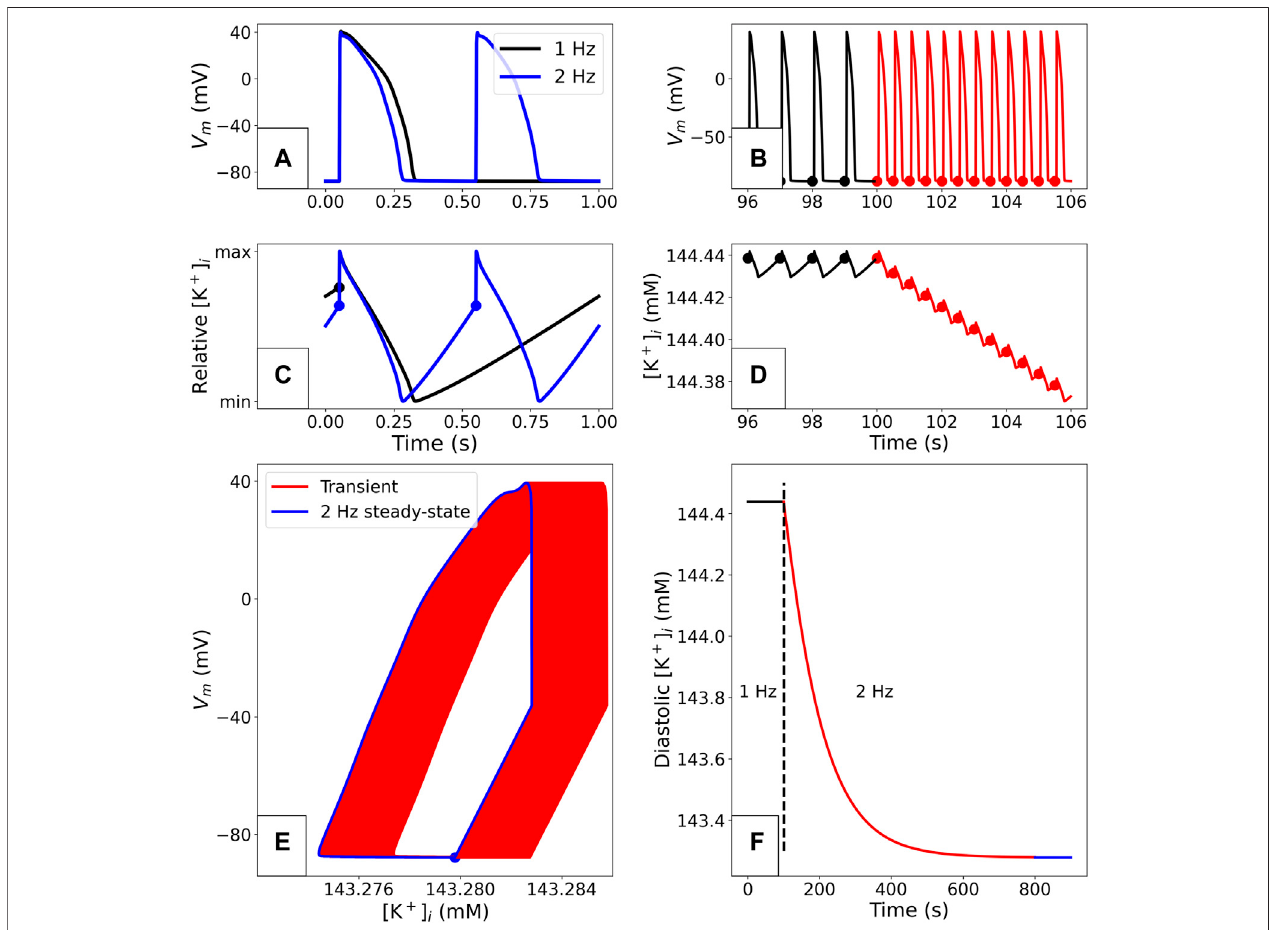
FIGURE 1 | Example of a limit cycle in the O ’ Hara-Rudy CiPA 2017 model (Dutta et al., 2017), using the initial conditions from the published CellML model. The simulation methods are detailed in “ Simulation ” . (A) : Comparison of paced steady-state APs with 1 and 2 Hz pacing. (B) : Adaptation of the voltage pro fi le when the pacing rate is suddenly changed from 1 to 2 Hz. The dots plotted on the traces correspond to the end of the diastolic phase in each AP. (C) : Comparison of periodic steady-state [ K + ] i variations during the AP with 1 and 2 Hz pacing. The values are normalised for easier comparison. (D) : Adaptation of [ K + ] i after the sudden changeto2 Hzshown inpanel (B) . (E) : V m and [ K + ] i duringthetransientadaptationphase where themodelconverges towardsits periodic steadystate.Dataisshown from the 500th pace onward. After a slow drift of [ K + ] i over time, a limit cycle (in blue) is reached where the patterns from consecutive APs overlap. (F) : Evolution of diastolic intracellular potassium (measured at the time points denoted with dots in B and D) after a change in pacing rate. A limit cycle is reached after approximately 700 2 Hz